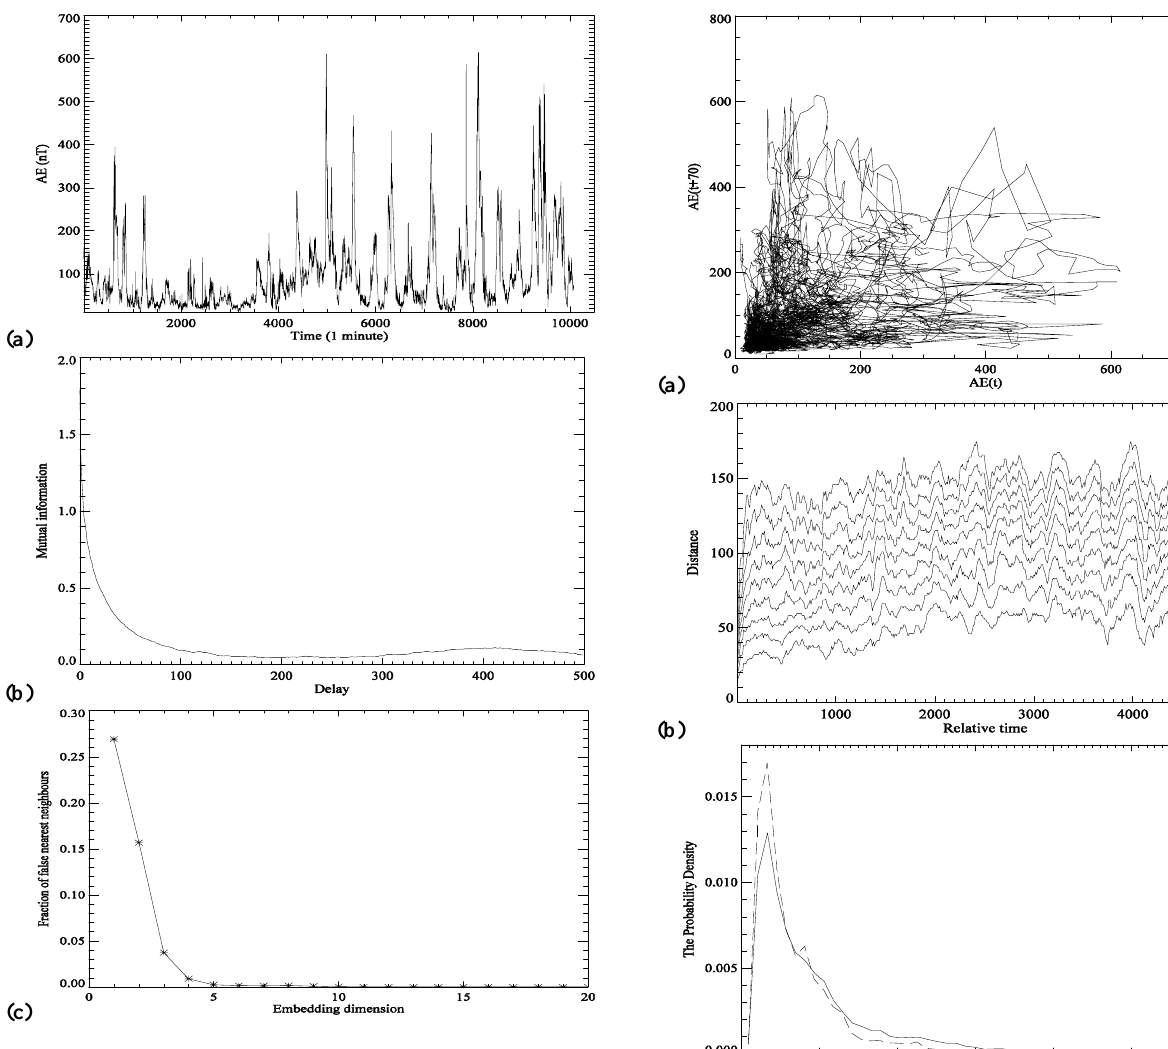
Fig. 1. (a) Time series of AE index, (b) mutual information of the time series as a function of delay, and (c) fraction of false nearest neighbours as a function of the embedding dimension m with τ =70, during the quiet period, 5–11 January 1991.